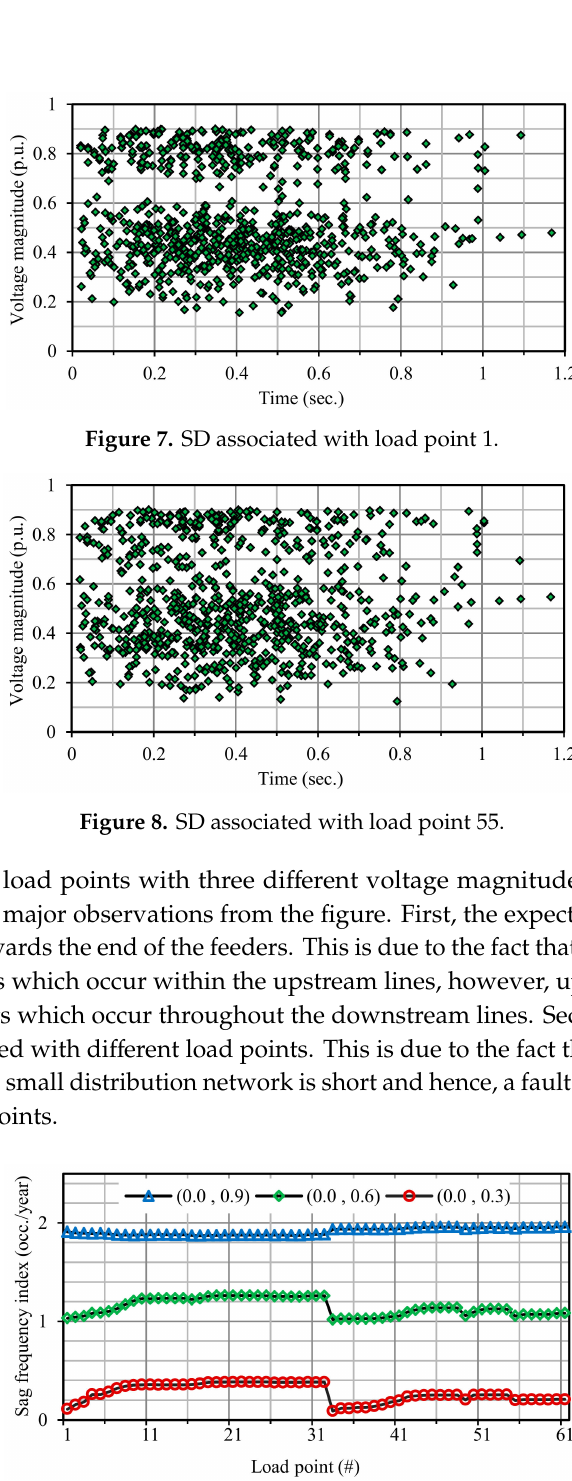
Figure 9. SFI with three di ff erent voltage magnitude thresholds associated with load points in the